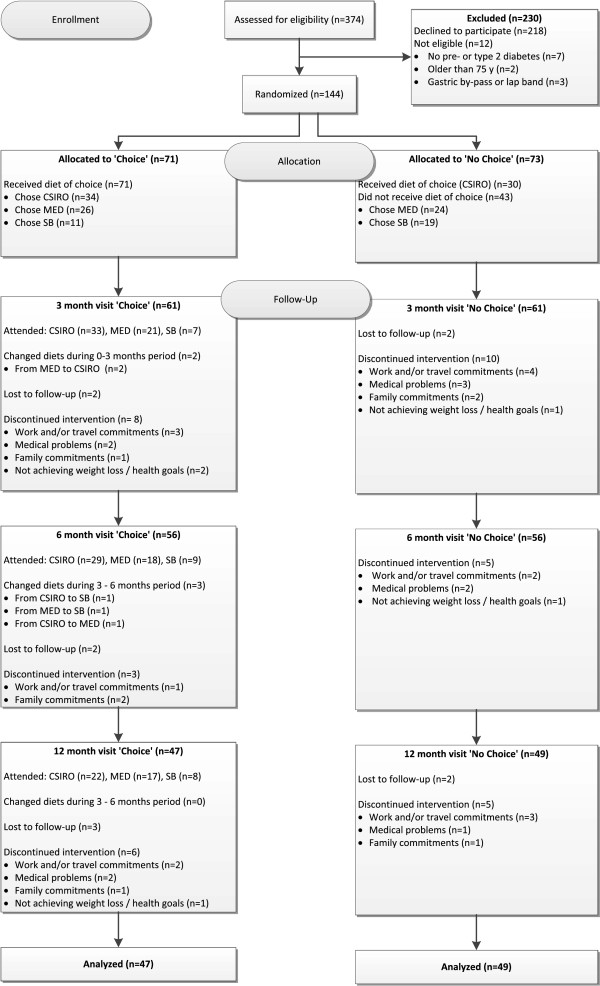
CONSORT-style flow chart.